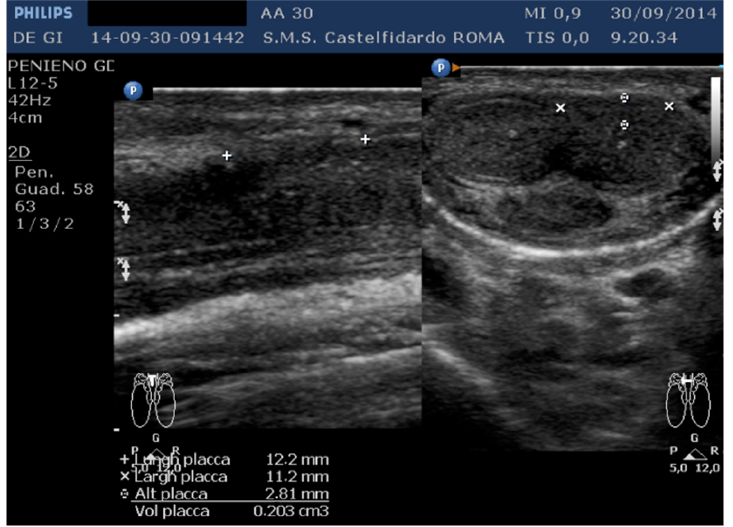
Figure 12. Ultrasonography of the penis and measurement of plaque before treatment (longitudinal and transverse views).